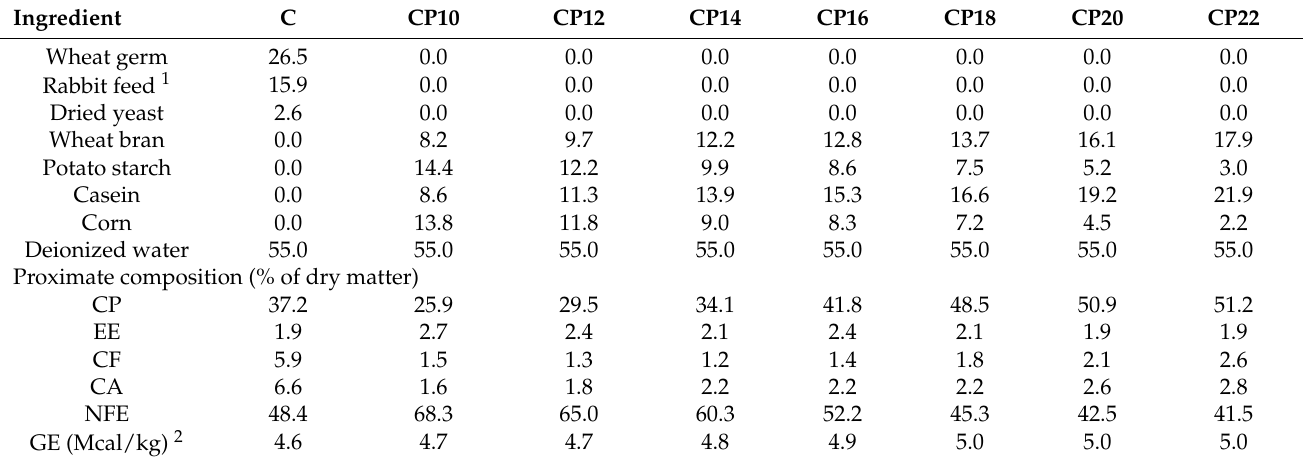
Table 1. Ingredients and proximate composition of diets in Experiment